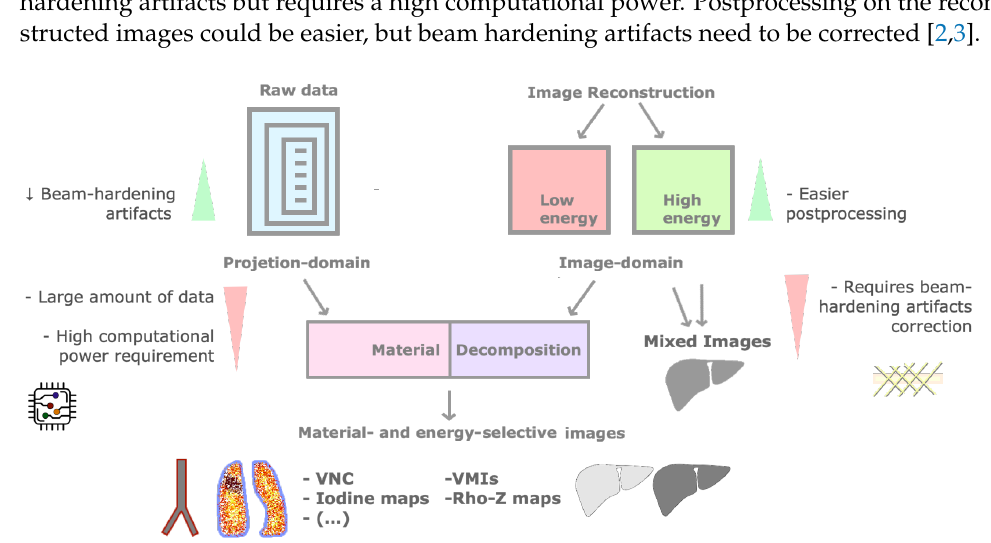
Figure 4. Postprocessing in DECT imaging. Postprocessing may be performed before (raw data or projection-space domain) or after (image-space domain) the reconstruction of high- or low-energy images. The former has reduced beam-hardening artifacts but requires high computational power. Material decomposition algorithms generate material- and energy-selective images. Iodine may be subtracted from material-specific images, generating a virtual non-contrast image (VNC), or color-coded, creating iodine maps. Virtual monochromatic images (VMIs) mimic single-energy scans. Mixed images are mostly used for routine diagnostic interpretation.